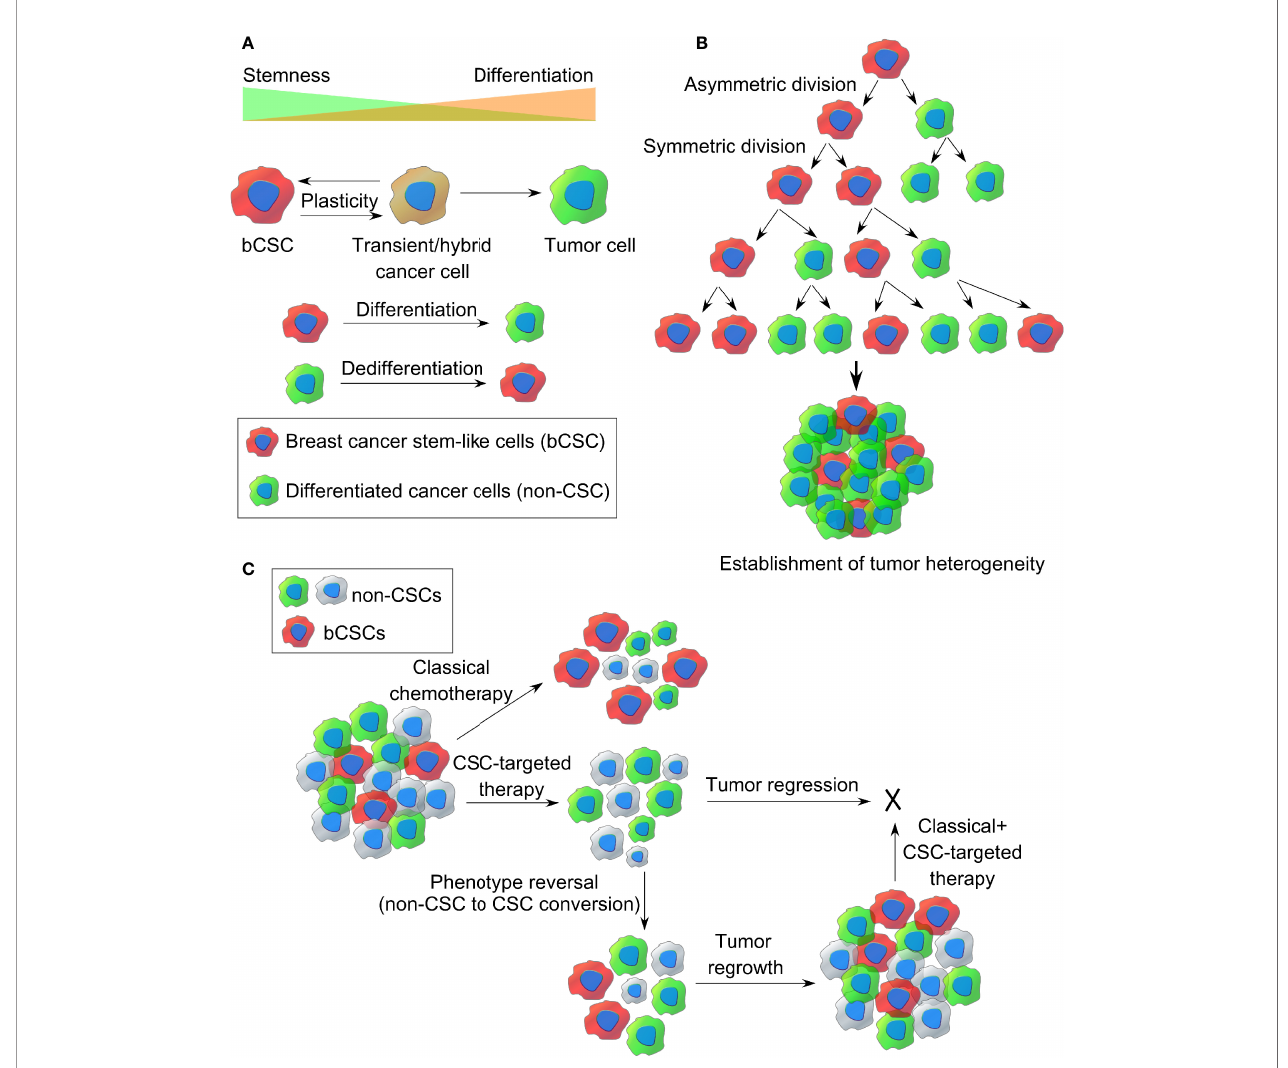
FIGURE 2 | The origin of breast CSCs within a tumor. (A) Dynamic cancer stem cell (CSC) model of cancer cell plasticity showing switching between CSC-like state and differentiated cancer cell states (non-CSCs) through differentiation and dedifferentiation pathways. (B) Establishment of intratumor heterogeneity in breast cancer, resulting from symmetric and asymmetric cell divisions of breast CSCs. (C) Representative images of classical chemotherapy, CSC-targeted therapy, phenotype reversal, and combination therapy for target killing of breast cancer stem-like cells from